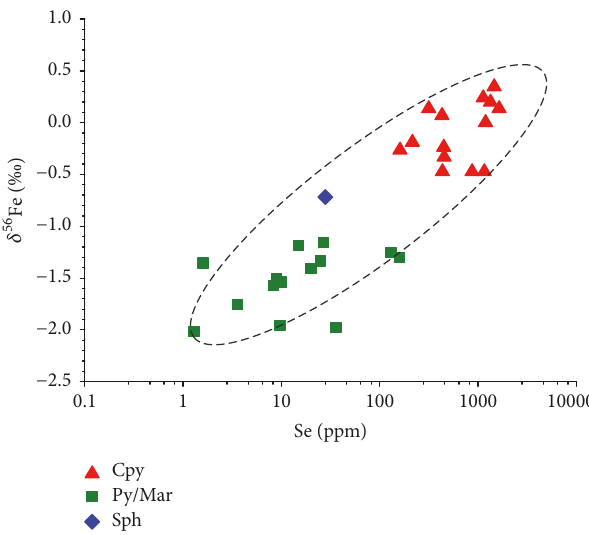
Figure 4: Se content versus 𝛿 56 Fe values of hydrothermal sulfides (after